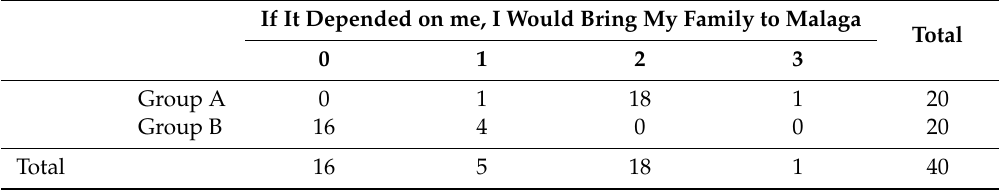
Table 13. E ff ect of the learning group on expectations of moving the family to Malaga. If It Depended on me, I Would Bring My Family to Malaga